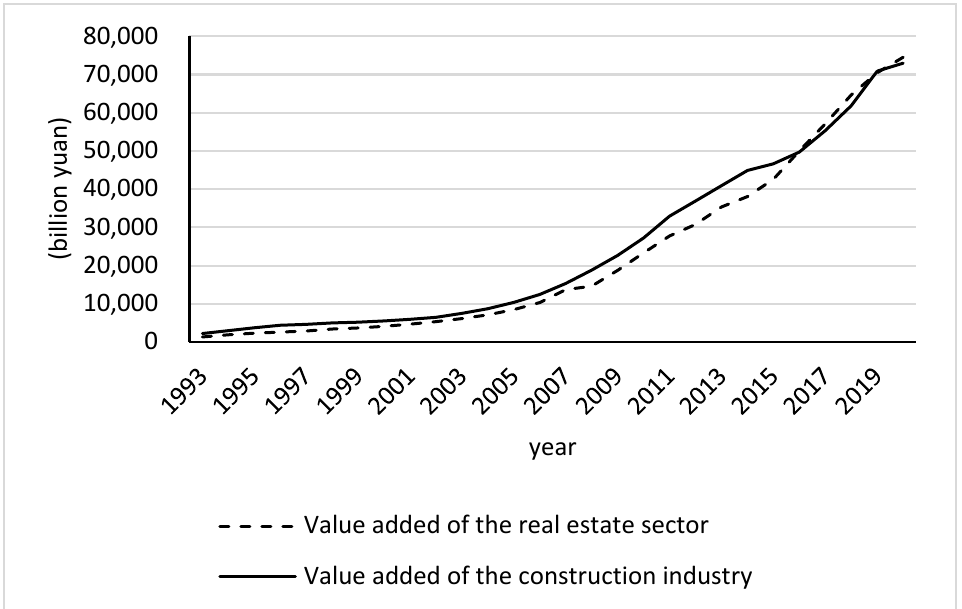
Figure 3. China’s real estate value added and construction value added.